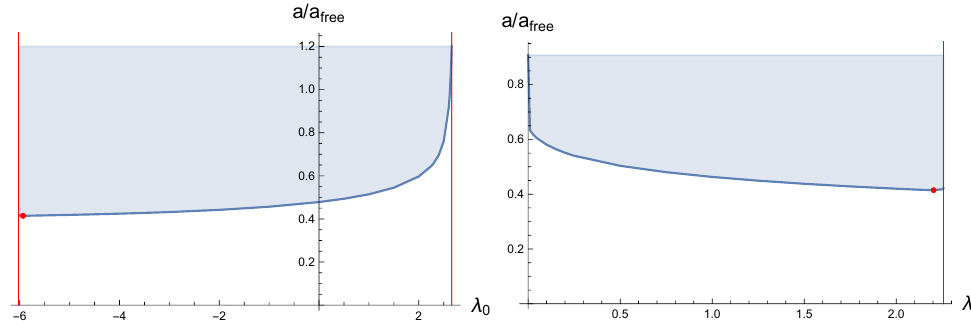
Figure 2 . Minimum of the a -anomaly of the UV CFT as a function of the parameters λ 0 and λ 2 defined in (1.3). The red dot marks the absolute minimum. The red vertical lines indicate the boundaries of the allowed regions for λ 0 and λ 2 .